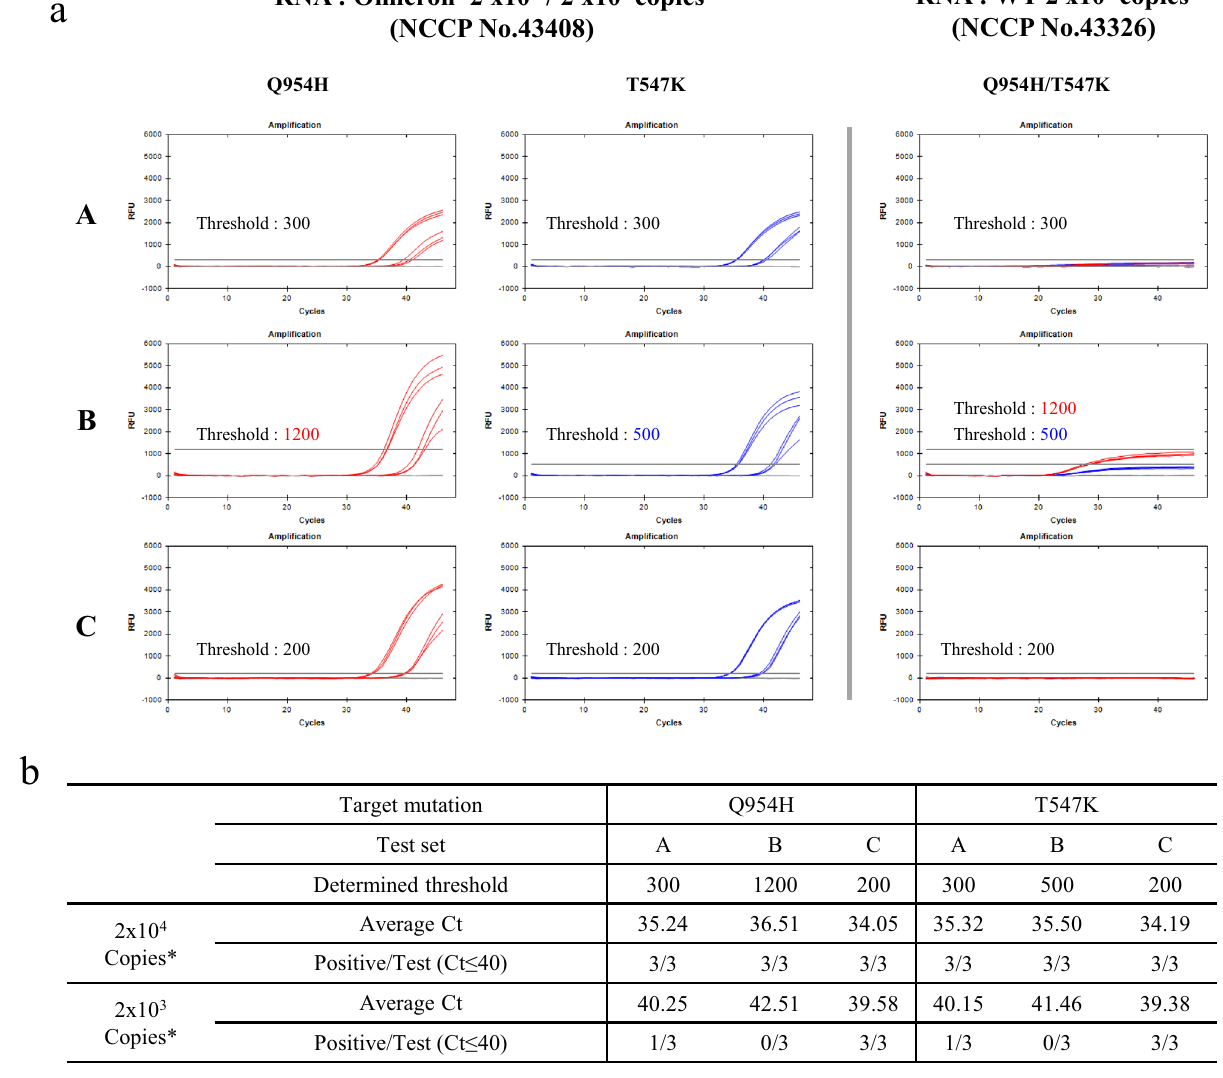
Figure 5. STexS II validation using standard RNA samples of the SARS-CoV-2 Omicron variant. Validation of signal enhancements and nonspecific signal diminish by Com probes within Omicron variant RNA samples. ( a ) PCR and Ct value of Omicron region Q954H. Each trial was performed 3 times for statistical comparison. PCR experimental order is identical to Fig. 4. ( b ) Information regarding the above PCR trial and results of positive